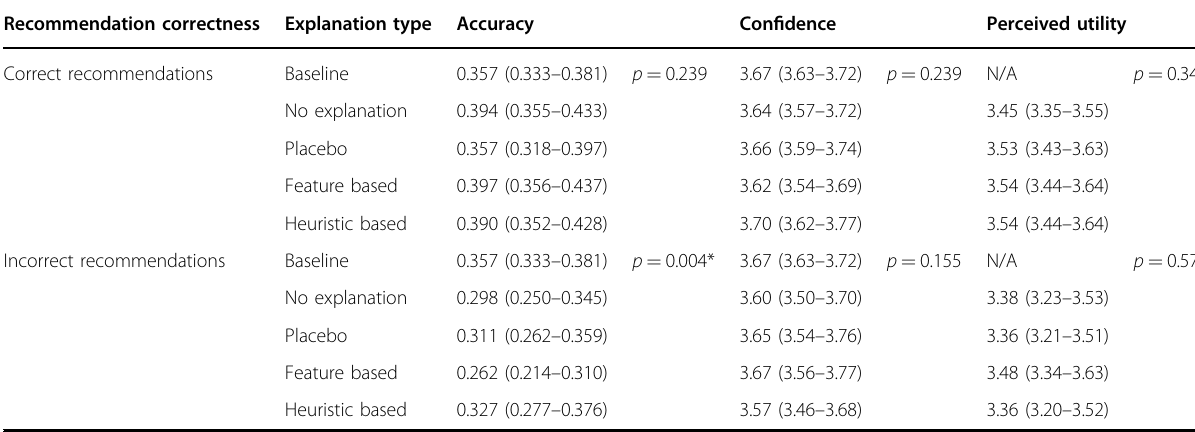
Table 3 Accuracy, con fi dence, and utility scores strati fi ed by explanation type for correct and incorrect